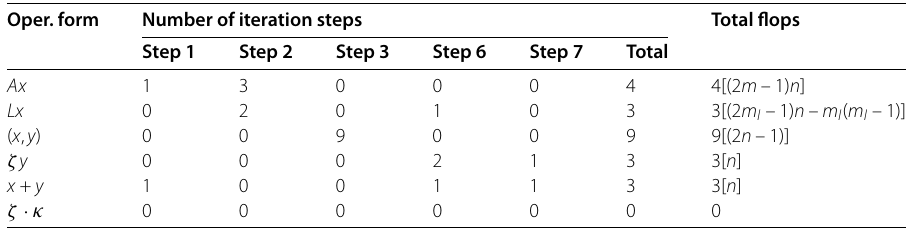
Table 1 Operation forms and flops at each step of the iteration Oper. form Number of iteration